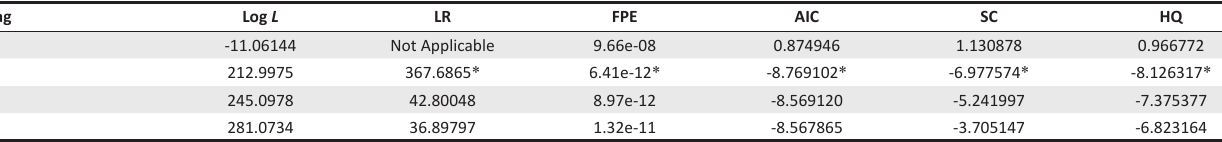
TABLE 2: Vector autoregression lag order selection criteria, 1980–2012. Lag